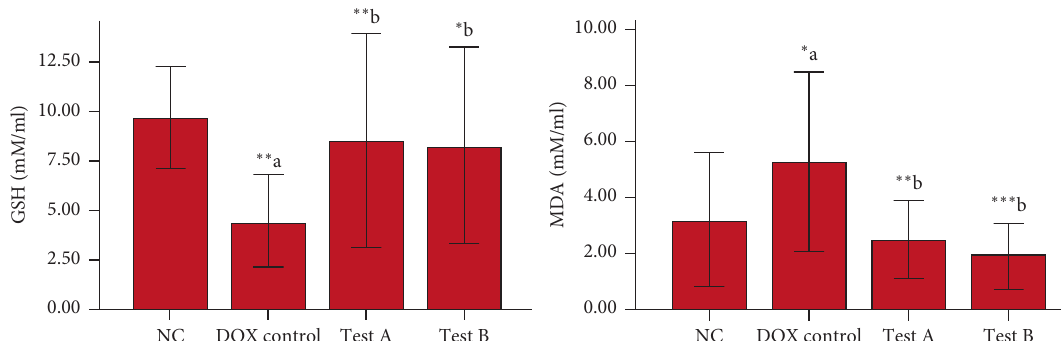
Figure 5: Effect of DOX and methyl gallate on oxidative stress markers. Data were represented as mean ± SD, one-way ANOVA followed by Tukey’s post hoc test ( ∗ ∗ ∗ p ≤ 0.001, ∗ ∗ p ≤ 0.01, and ∗ p ≤ 0.05; a compared to control and b compared to DOX control), NC: normal control, test-A: methyl gallate 150mg/kg, and test-B: methyl gallate 300mg/kg.